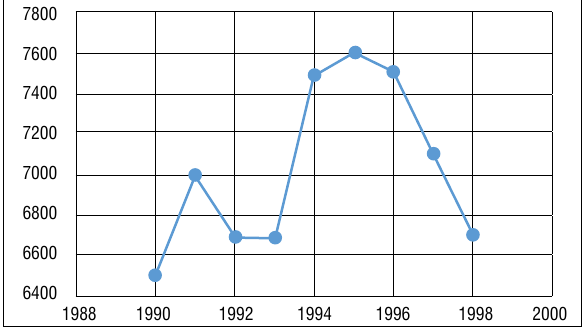
Research output of South African universities.